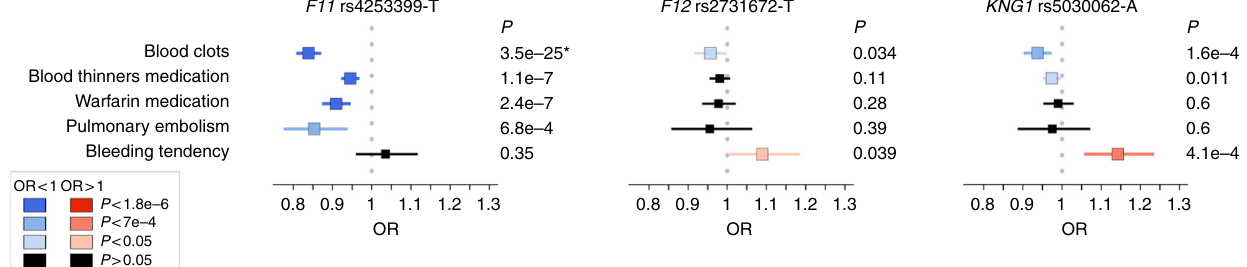
Fig. 4 PheWAS for contact activation coagulation pathway targets. Three SNPs known to affect plasma protein levels of FXI (rs4253399), FXII (rs2731672), and KNG1 (rs5030062), and previously reported associated with partial thromboplastin time (aPTT) were interrogated in meta-PheWAS. Five phenotypes were observed as signi fi cantly associated (FDR < 0.1) with at least one of the three SNPs: blood clots (23andMe, FINRISK, and CHOP: 7487 cases, 273,305 controls), known association with the F11 SNP (*), blood thinners medication (23andMe: 22,985 cases, 236,431 controls), warfarin medication (23andMe: 7142 cases, 94,701 controls), pulmonary embolism (Gplc/UK Biobank: 949 cases, 111,077 controls), and bleeding tendency (23andMe: 1574 cases, 85,223 controls). Odds ratios (OR) and 95% con fi dence intervals of association of the aPTT-increasing alleles are shown. Detailed association results are provided in the Supplementary